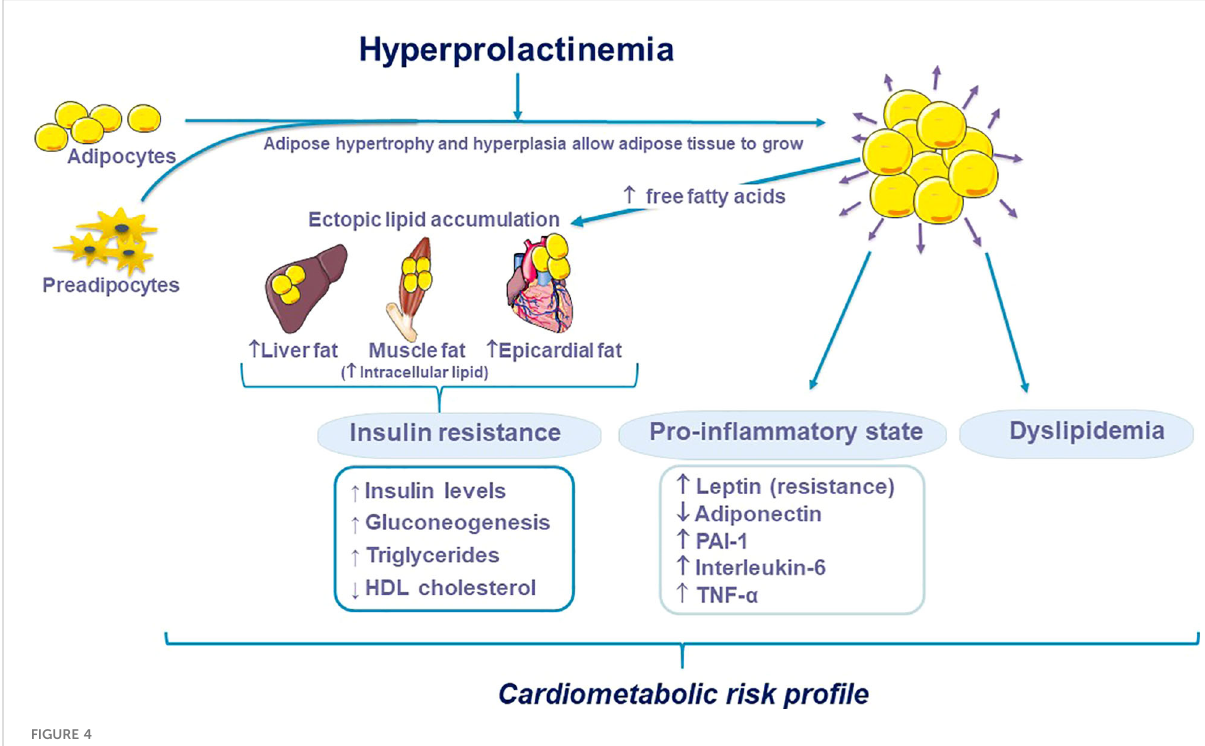
FIGURE 4 Potential role of hyperprolactinemia on adipose